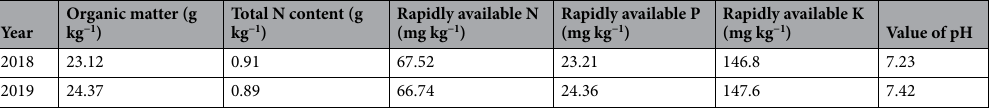
Table 1. The physicochemical property of composite topsoil samples (0–20